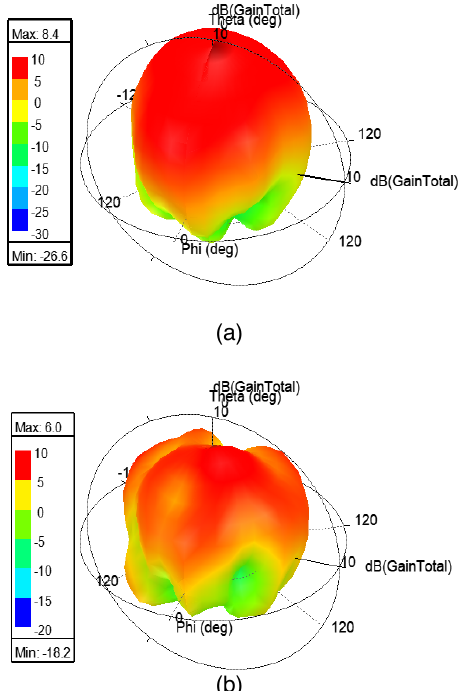
FIGURE 11. The MIMO antenna 3D radiation patterns (a) 28 GHz and (b) 38